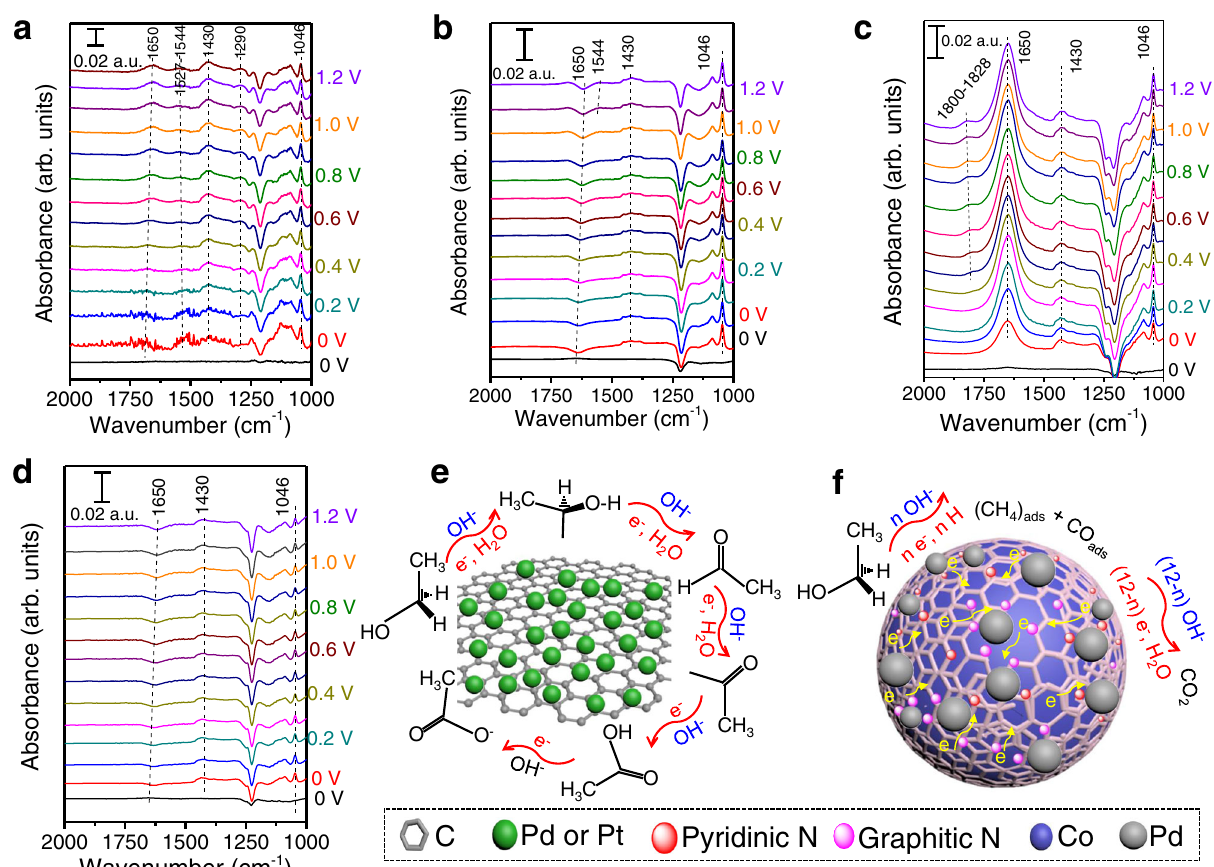
Fig. 4 | Mechanistic study of reaction pathway for EOR based on in-situ ATR- SEIRASmeasurements. In-situATR-SEIRAspectrameasuredatdifferentpotentials for a Pd/C, b Pd/N-C, c Pd/Co@N-C, and d Pd+Co@N-C in 0.1M KOH+1.0M EtOH aqueous solution. The reference spectra (black lines) in (a-d) were obtained at 0 V RHE in0.1MKOHaqueoussolution.TheproposedEORmechanismsfor e Pd/C(or